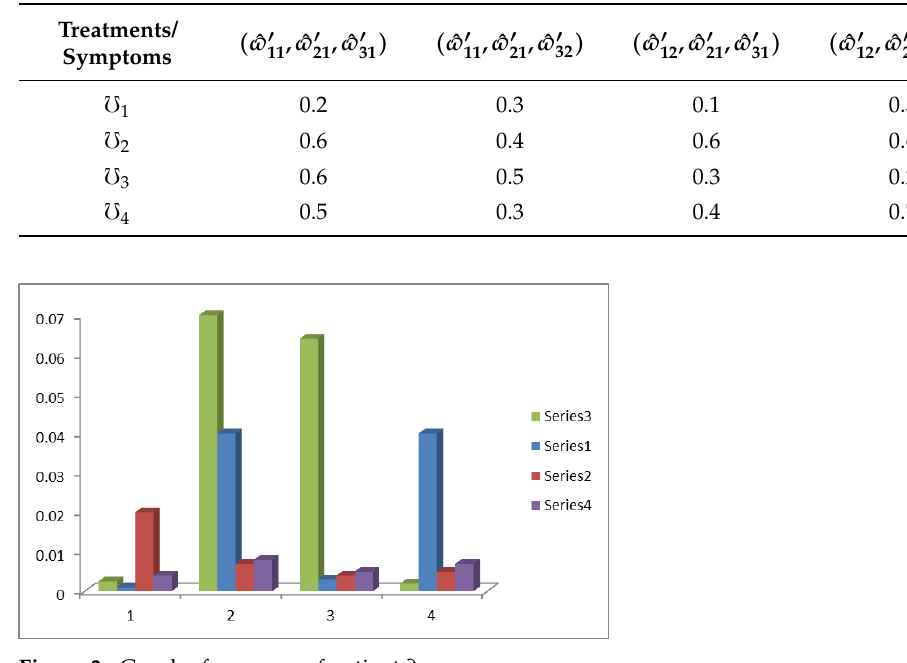
Figure 3. Graph of progress of patient ∂ 1 .